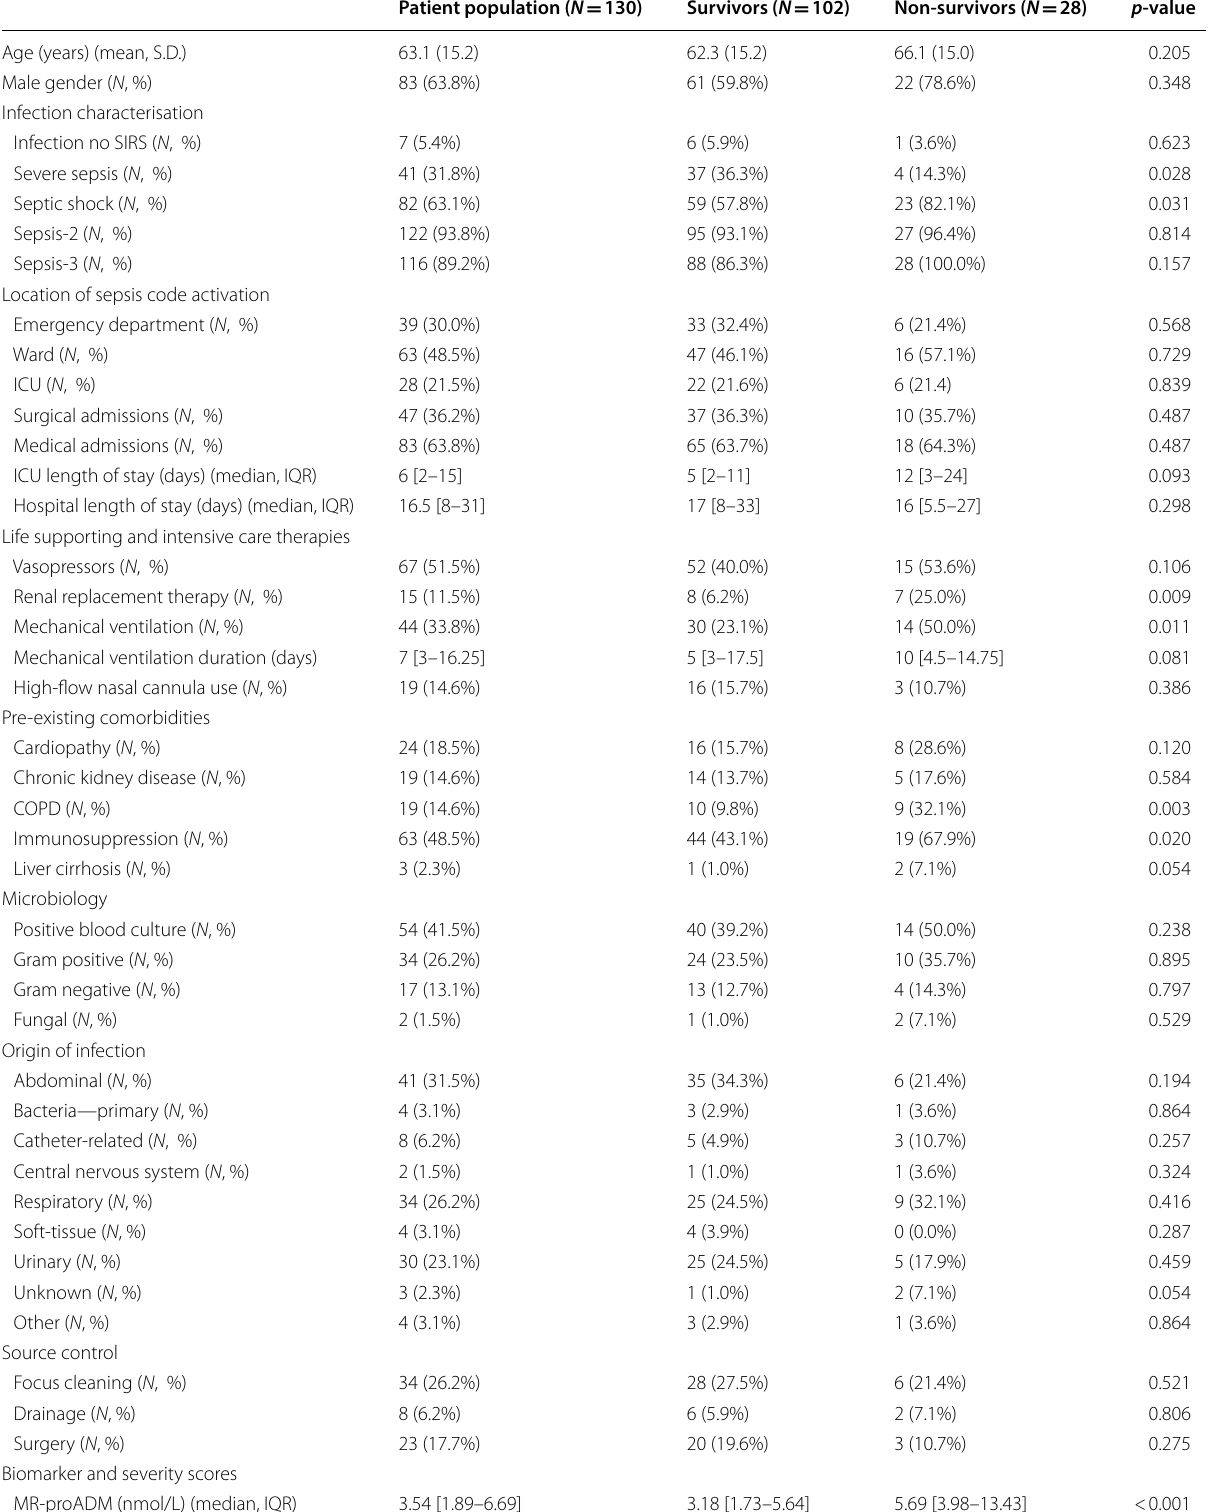
Table 1 Clinical patient characteristics upon activation of the sepsis code with respect to the total infected patient population and subsequent 28-day